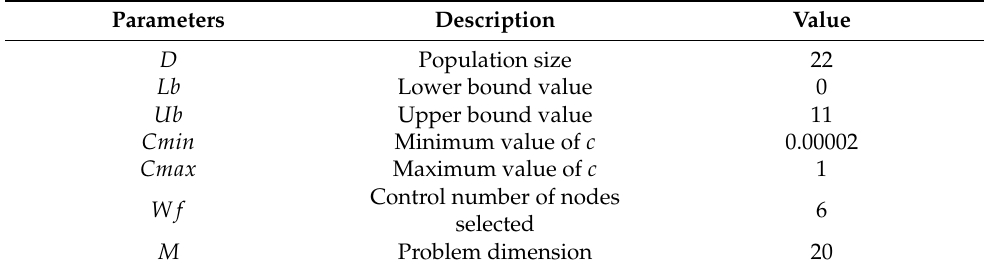
Table 1. Parameter setting of MGOA.